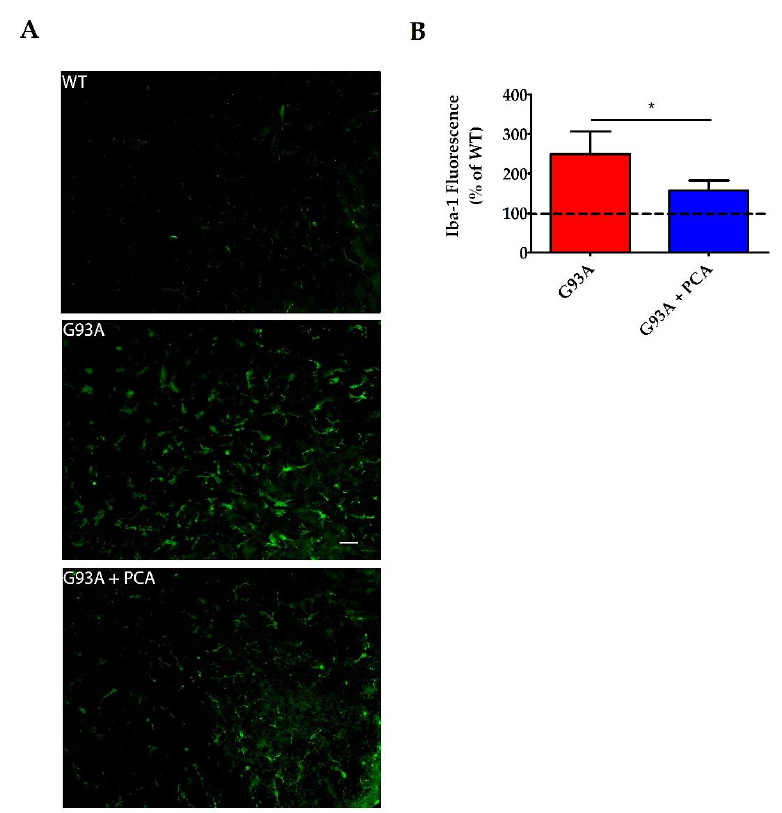
stained for GFAP from wildtype control mice (WT), untreated hSOD1 G93A mice (G93A), and hSOD1 G93A mice treated orally with 100 mg / kg PCA beginning at disease onset (G93A + PCA). Mice were euthanized at end stage of the untreated hSOD1 G93A littermate control mouse and ventral horns were stained with an antibody to GFAP to label astrocytes. Scale bar = 20 µ m. ( B ) Quantification of spinal cord ventral horns stained with GFAP as described in A. GFAP fluorescence intensity of untreated and PCA-treated hSOD1 G93A littermate mice were normalized and expressed as a percentage of GFAP fluorescence measured in the WT littermate control mouse. Data are expressed as the mean ± SEM; n = 10 mice per group; 4–6 ventral horns were imaged per mouse. * indicates p < 0.05 compared to untreated hSOD1 G93A controls (paired t -test). Raw mean GFAP fluorescence units for the untreated hSOD1 G93A mice ((3.21 ± 0.46) × 10 6 ) are significantly higher than the WT ((0.97 ± 0.16) × 10 6 ) ( p = 0.001; n = 10 mice per group).